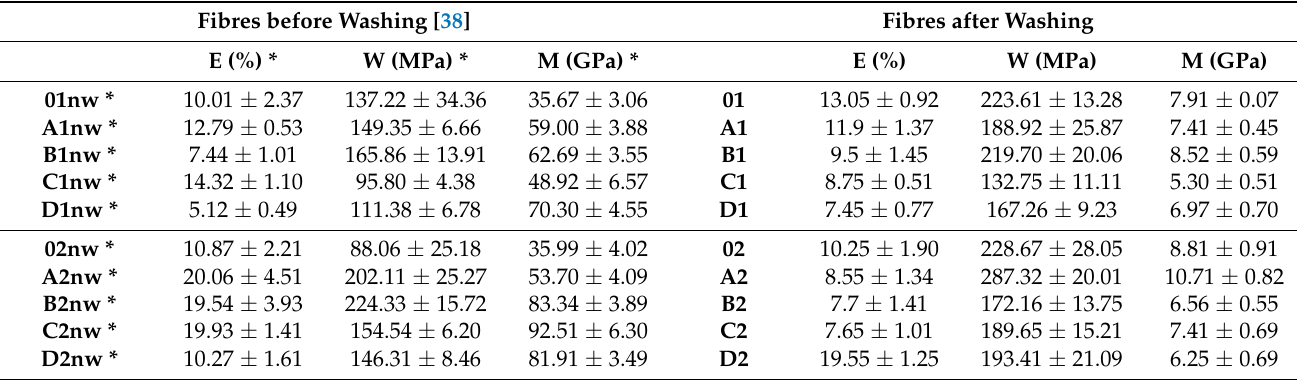
Table 4. Mechanical test